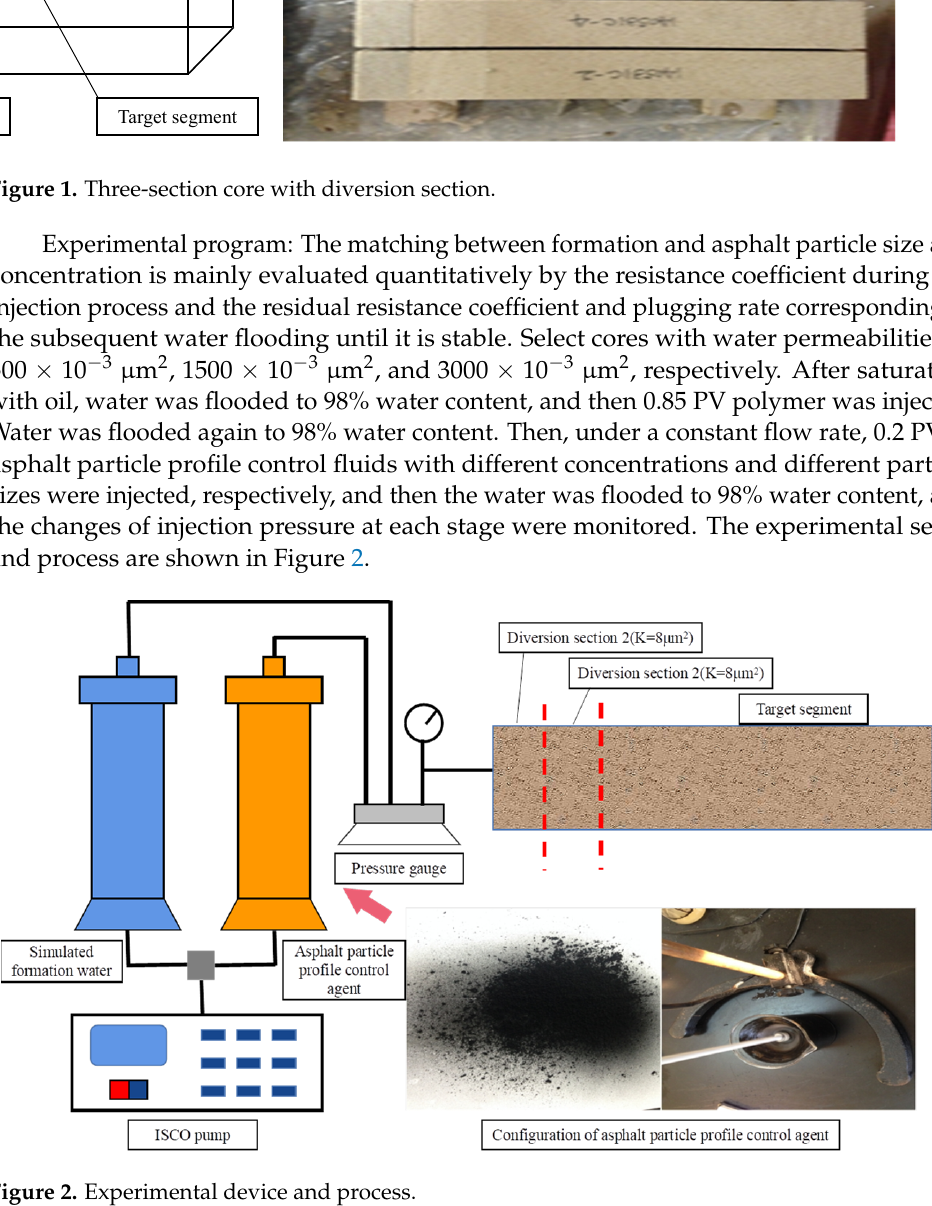
Figure 2. Experimental device and process.